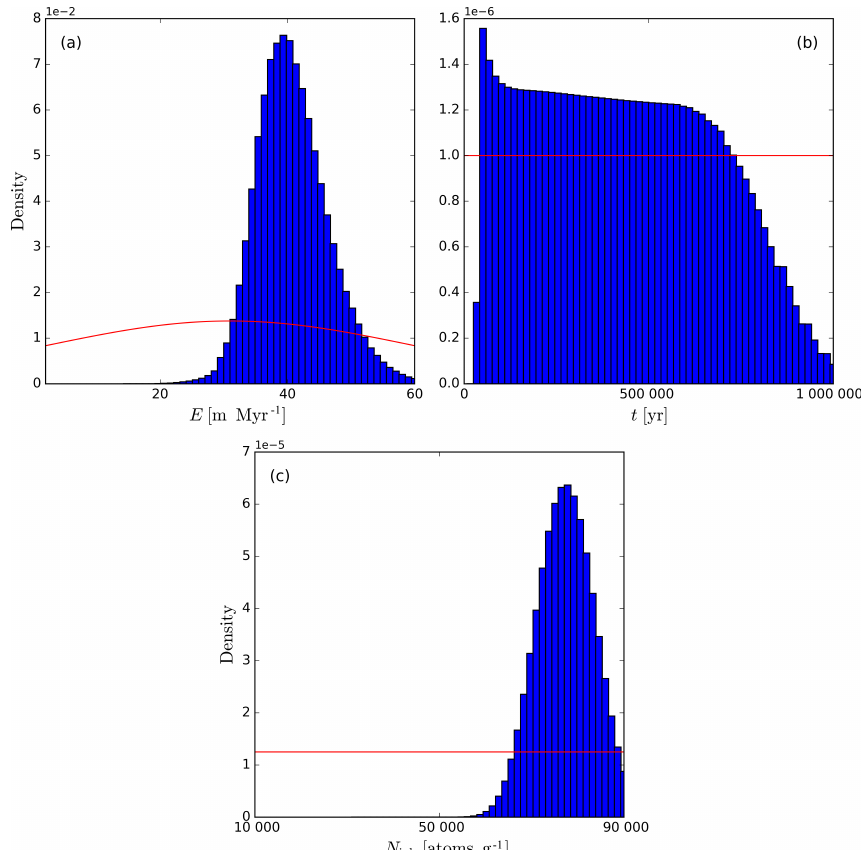
Figure 10. Marginal posterior distributions of the three sampled parameters using the Bayesian approach taken in the CRONUScalc program: (a) erosion rate, (b) exposure age, and (c) inherited 10 Be concentration. The blue bars denote the posterior PDFs and the red lines signify the associated prior